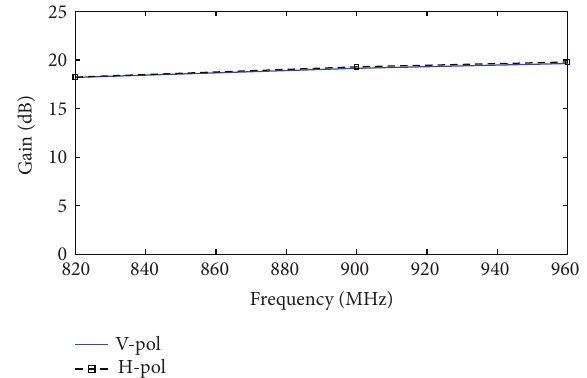
Figure 13: Measured gain of SAR-High antenna versus frequency at boresight: comparison between H and V polarizations.